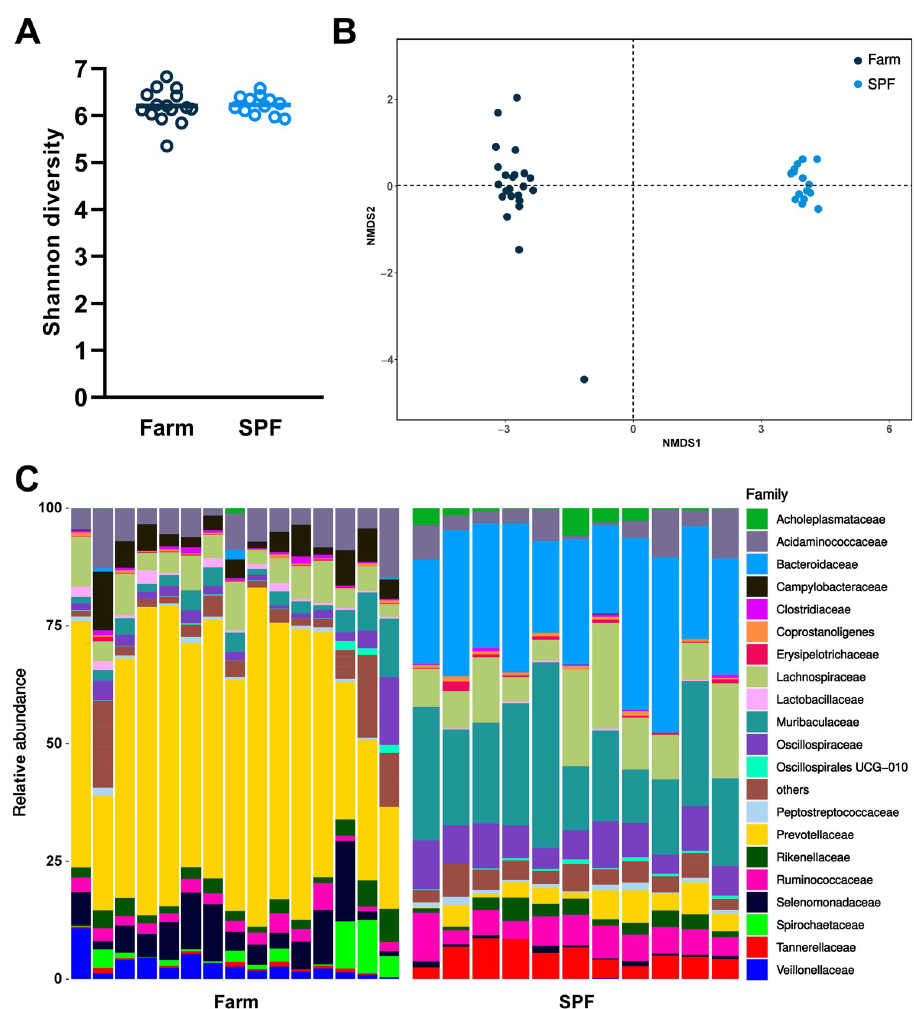
Fig 3. Fecal microbiota composition at steady state in farm and SPF pigs. (A,B) Shannon diversity and non-metric multidimensional scanning (NMDS) ordination of gut microbiome of pigs. Each data point represents the value for one animal. (C) Relative abundance of the most frequent bacterial families. Data are from 2 independent experiments (farm group n = 15; SPF group n = 11).